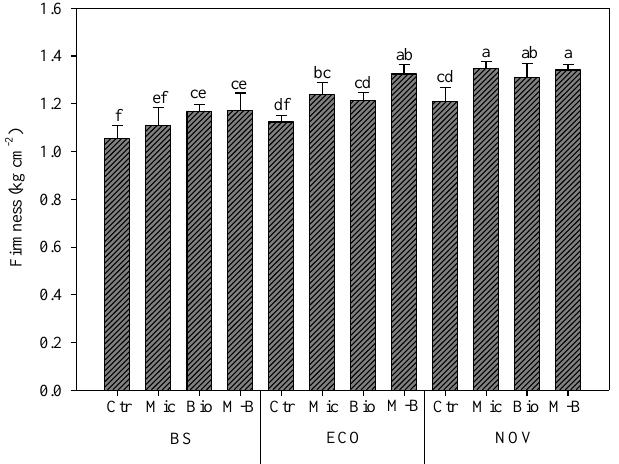
Figure 4. Total Soluble Solid (TSS) content of tomato fruits as affected by interaction mulching (ECO: biodegradable film Ecovio; NOV: biodegradable film MaterBi ® ; BS: bare soil) and biostimulant application (Bio: treated with Phylgreen ® ; Mic: treated with Trianum-P ® ; M-B: combination of Bio and Mic; Ctr: not treated). Each column indicates the mean value of the three replicates. Vertical bars indicate standard error; different letters indicate significant differences according to Tukey’s test ( p < 0.05).